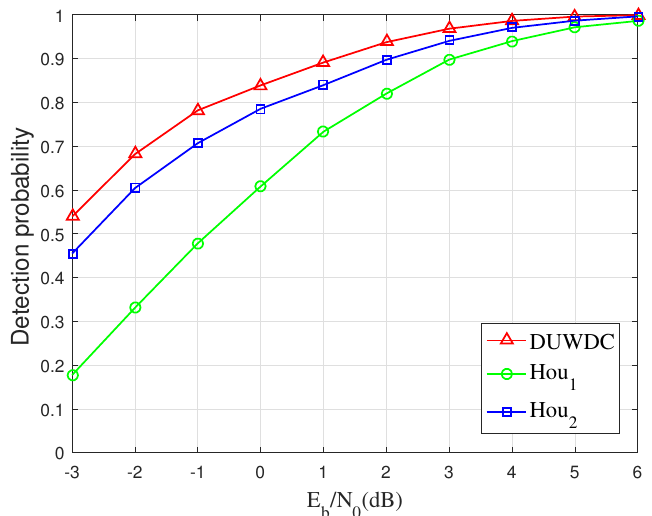
Figure 13. Relationship curve between the detection probability and